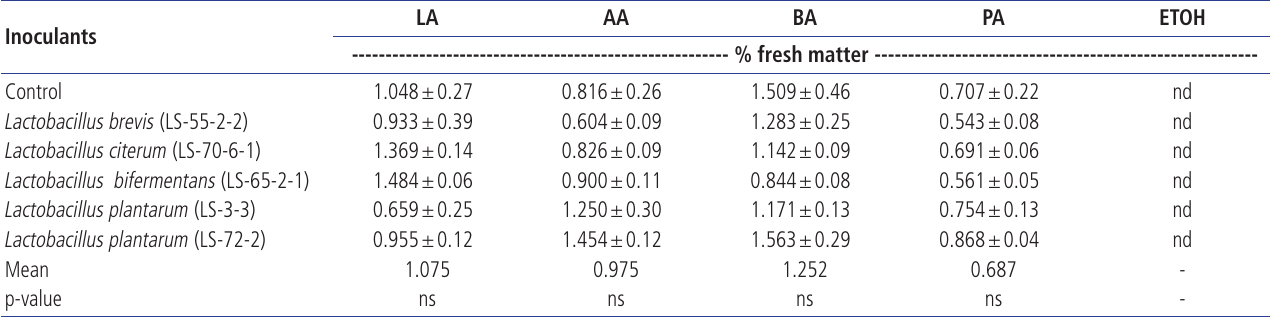
Table 5. Effects of different bacterial inoculants on volatile fatty acid contents of T